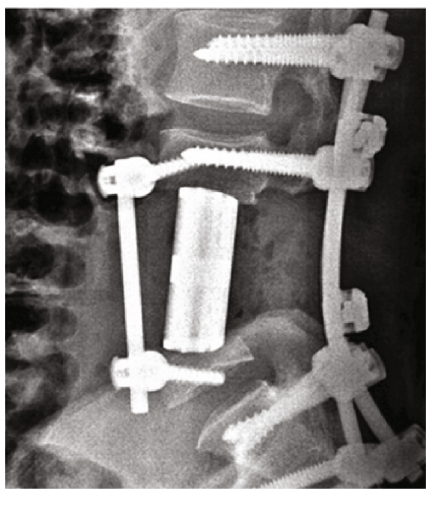
Figure 2: Case 2.